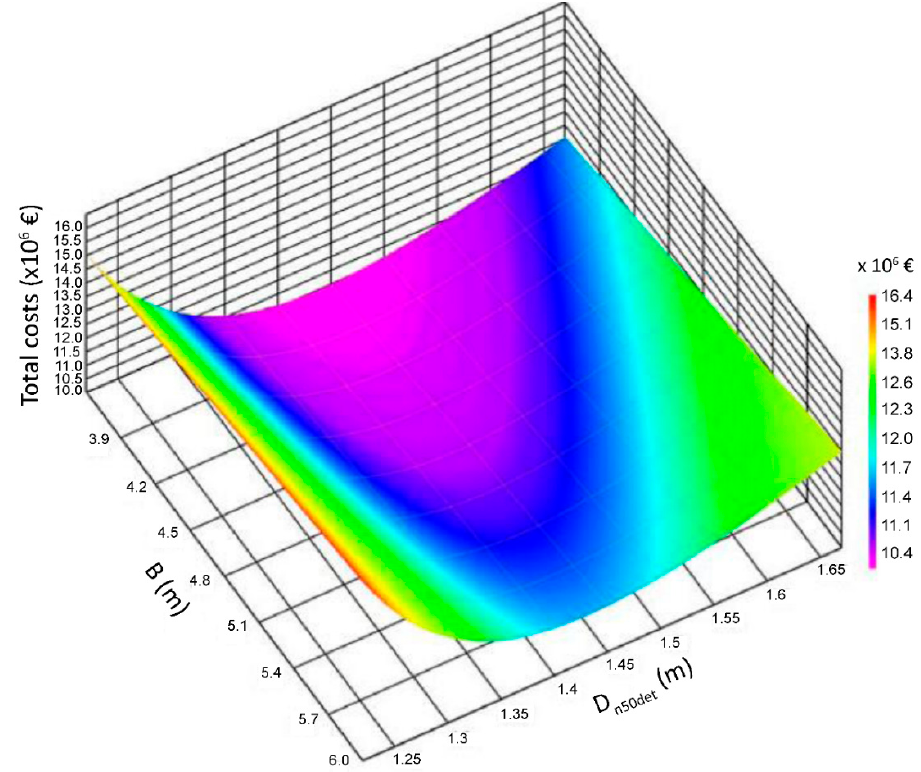
Figure 16. Total costs ( € ) as a function of the crest width, B (m), and the mean nominal diameter of rocks, D n 50det (m), for the detached low-crested structure of R cdet = − 1 m.